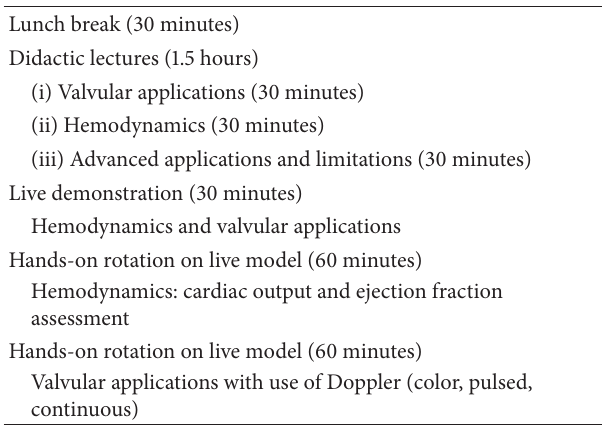
Table 1: Two-day critical care ultrasound course